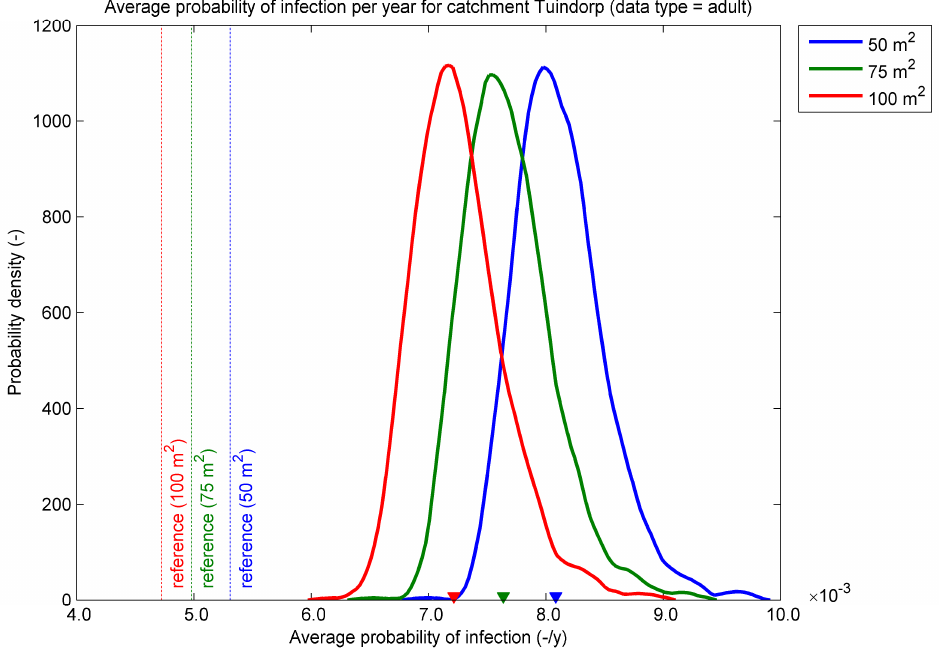
Figure 9. Infection probability for adults per year in the ‘Tuindorp’ catchment.